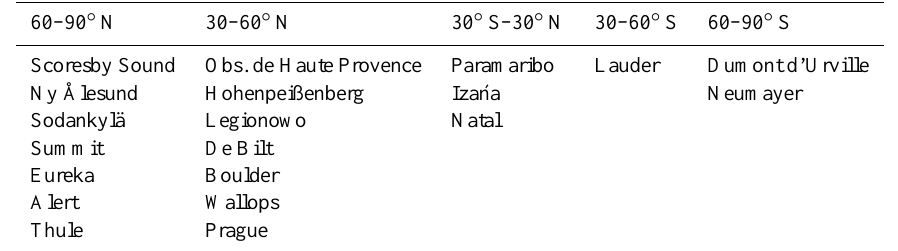
Table 2. NDACC stations that were used for different latitude zones.